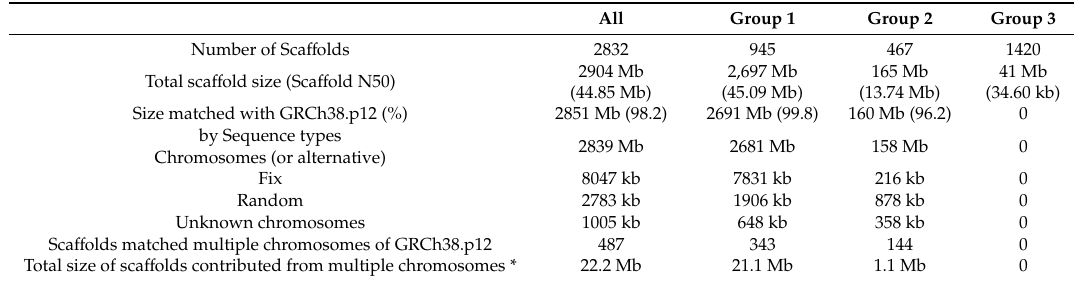
Table 1. Statistics of the three groups of AK1 sca ff olds according to a systematic comparison between AK1 sca ff olds ( n = 2382) and GRCh38.p12. Fix, the patches represent changes (error corrections or assembly improvements) to GRCh38 genome; Random, the unlocalized contigs of GRCh38; GRCh38.p12, Genome Reference Consortium Human Build 38 patch release 12; * Size of sum of minor contributing